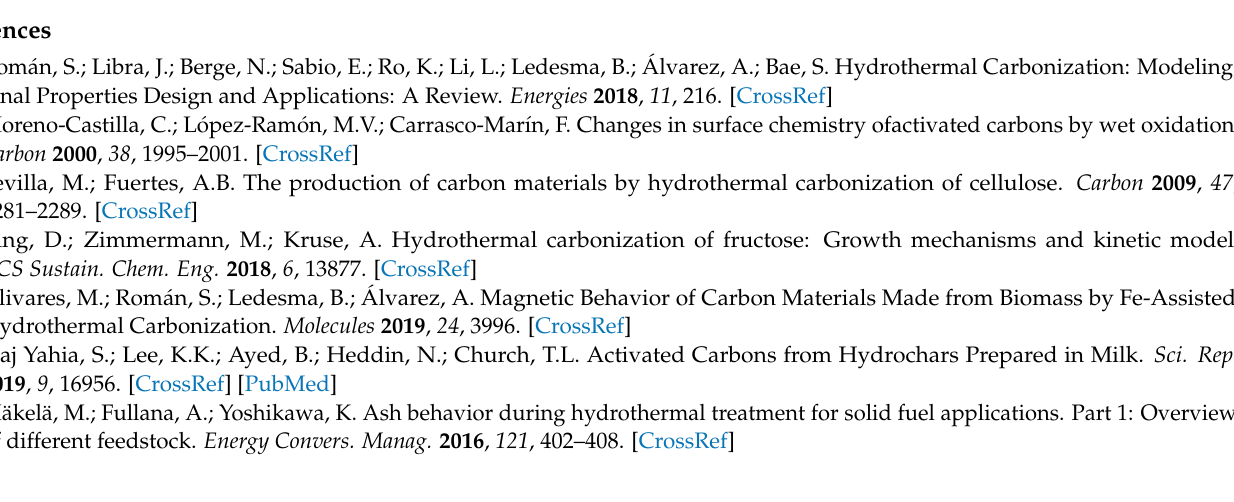
HC ( left ) and B 0 ( right